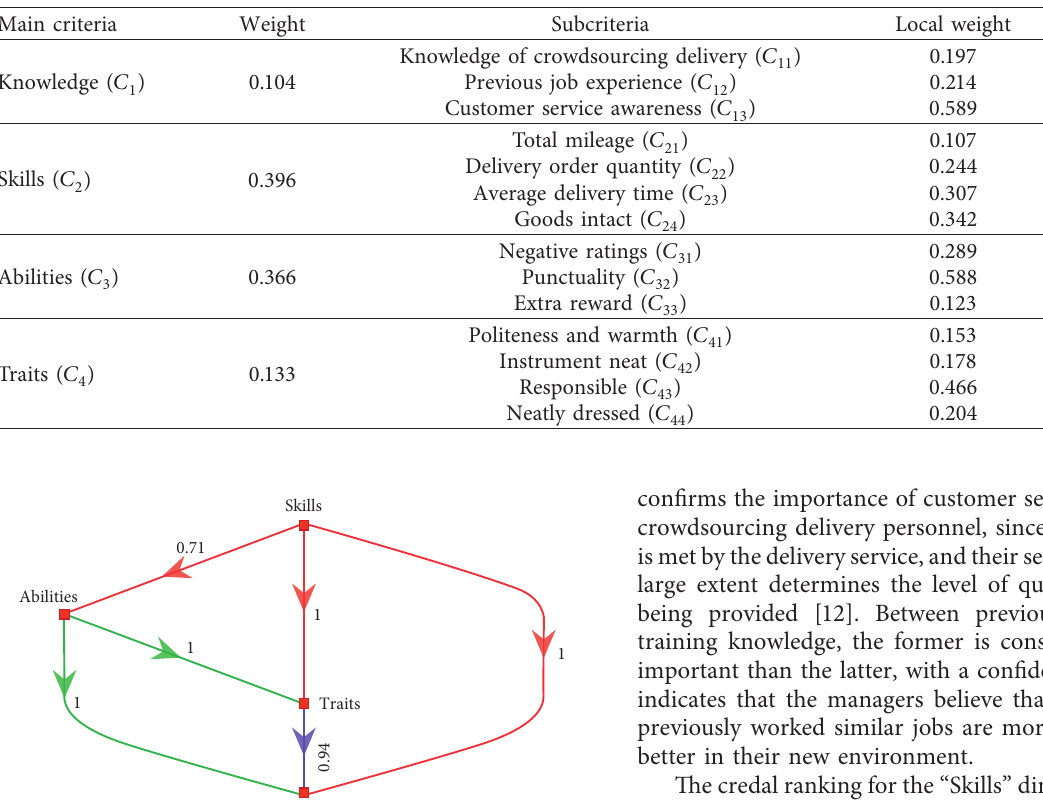
Table 3: Weights of main criteria and subcriteria.